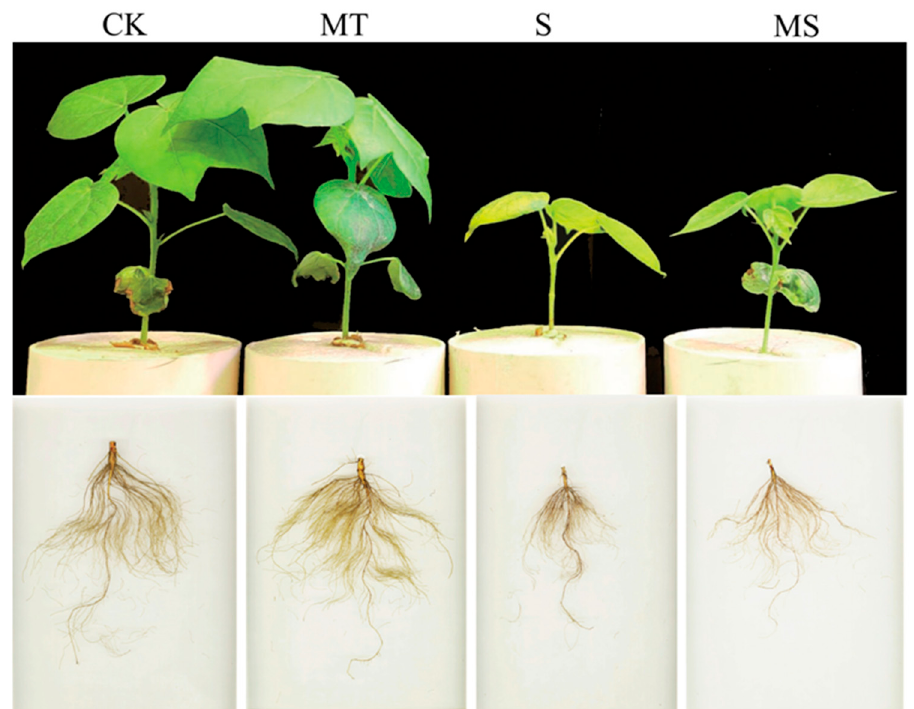
Figure 1. Dynamic changes in cotton plant shoots and roots under different treatments. The upper parts of cotton seedlings and their root systems after treatment with control conditions (CK), melatonin (MT), NaCl (S) and both melatonin and NaCl (MS) for 15 d. Cotton seedling root growth under salt stress (S and MS) was inhibited at 5, 10 and 15 d of treatment, and exogenous melatonin promoted root growth and development (MT and MS). On the 15th day, compared with the CK treatment, the total root volume, total lateral root number, average taproot diameter, taproot surface area and taproot volume under the MT treatment increased significantly by 37.84%, 19.40%, 38.03%, 81.55% and 11.32%, respectively; additionally, total root length, total surface area, total volume,